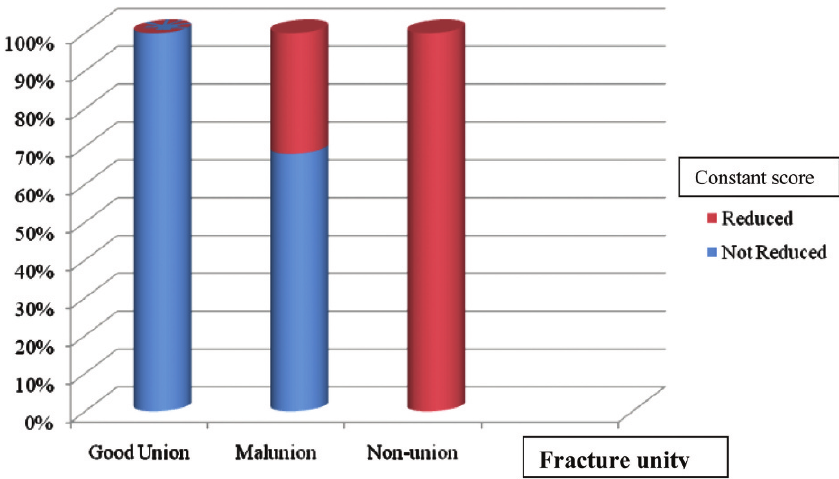
Figure 5 - Clavicle fracture unity and